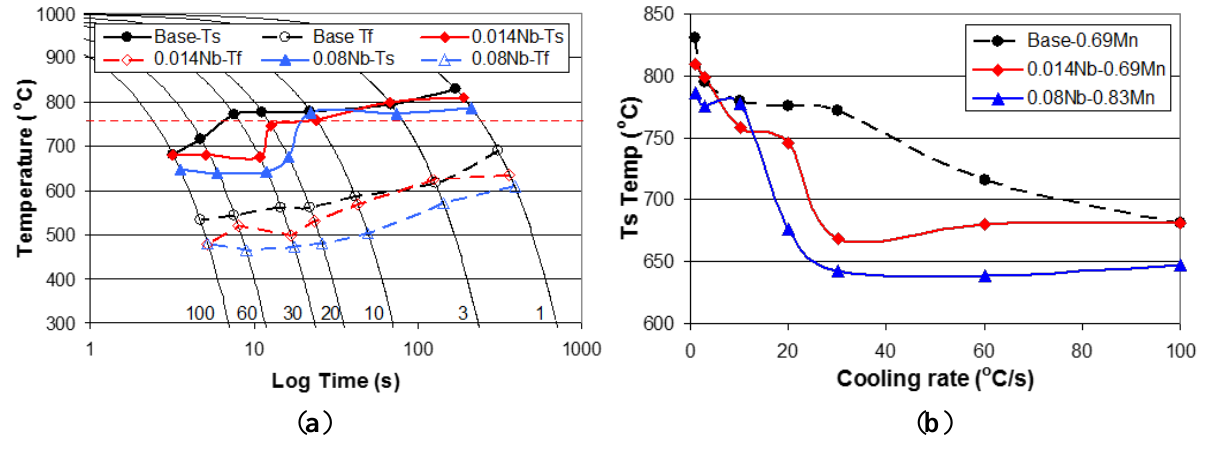
Figure 12. The effect of Nb on ( a ) the CCT diagram and ( b ) the Ts temperature as a function of cooling rate (Reproduced with permission from Killmore, Development of a Family of High Strength Low Carbon Microalloyed Ultra-Thin Cast Strip Products Produced by the CASTRIP® Process, MS&T 2010 Proceedings, AIST, Houston, TX, USA, 17–21 October 2010)